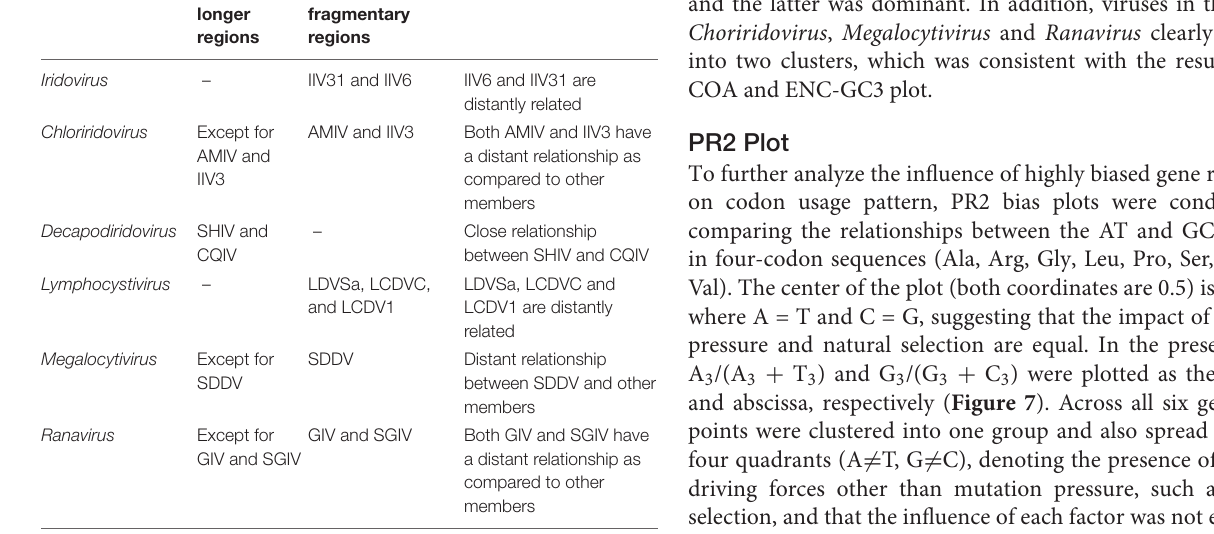
Frontiers in Microbiology |